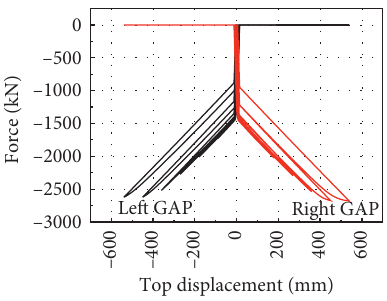
Figure 17: Curve of force versus top displacement of